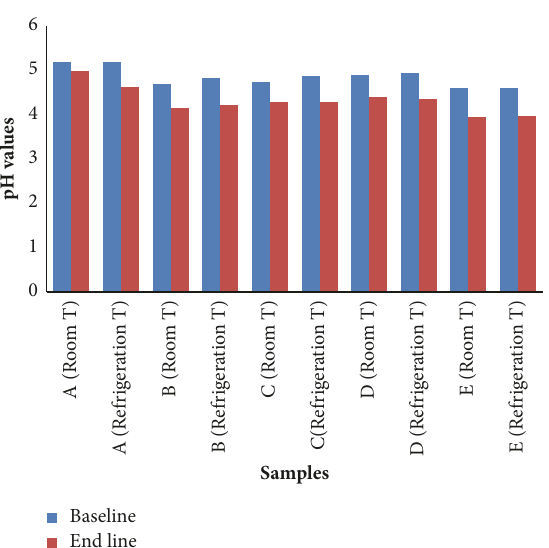
Figure 2: Changes in pH in OFSP puree during storage at ambient (15-25 ∘ C) and refrigeration temperature (4 ∘ C). A : puree without preservatives, B : puree with 0.05 % potassium sorbate+0.05 % sodium benzoate+1% citric acid, C : puree with 0.1 % potassium sorbate+0.1 % sodium benzoate+1% citric acid, D : puree with 0.2 % potassium sorbate+0.2 % sodium benzoate+1% citric acid, and E : puree with 1 % citric acid.